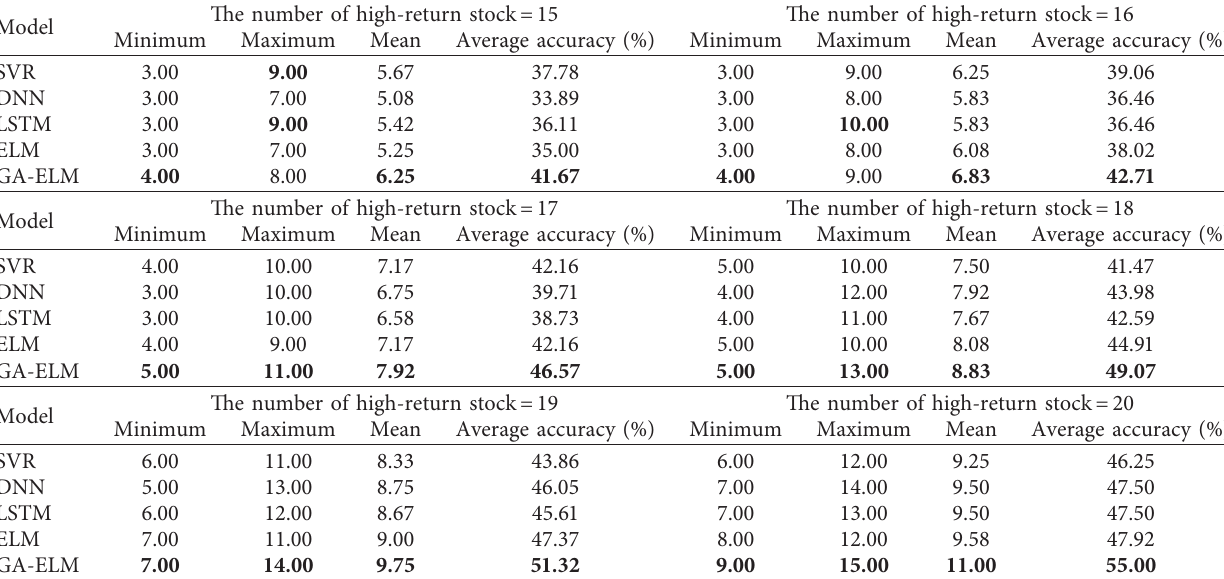
Table 3: Comparison of screening results obtained by different